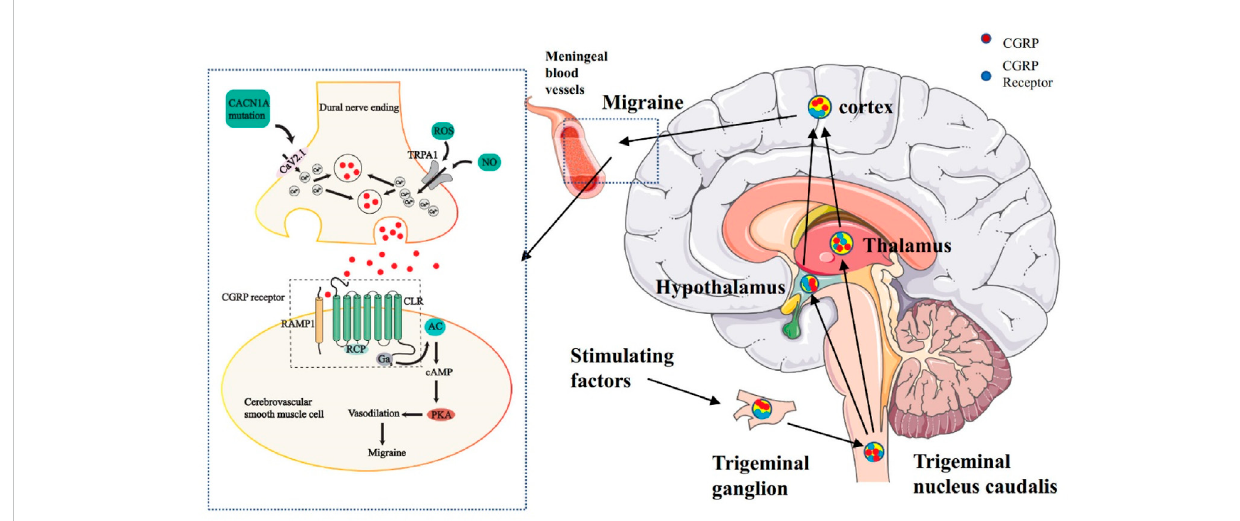
FIGURE 5 The dysfunction of the trigeminovascular system and energy metabolism can lead to migraine. The primary afferent nerve of the trigeminal nerve innervated the pia mater and dural meningeal vessels. Its efferent projection fi bers connect with secondary neurons in the TNC of the brainstem. The nerve fi bers of TNC project to the thalamus and then rise further to connect with the higher cortical area. At the junction of nerve endings and vascular smoothmuscle,ROSandNOjointlyactivatetheTRPA1channel,whichleadstocalciumin fl ux,stimulatesCGRPrelease,bindstotheCGRPreceptor of vascular smooth muscle, and then leads to vasodilation and